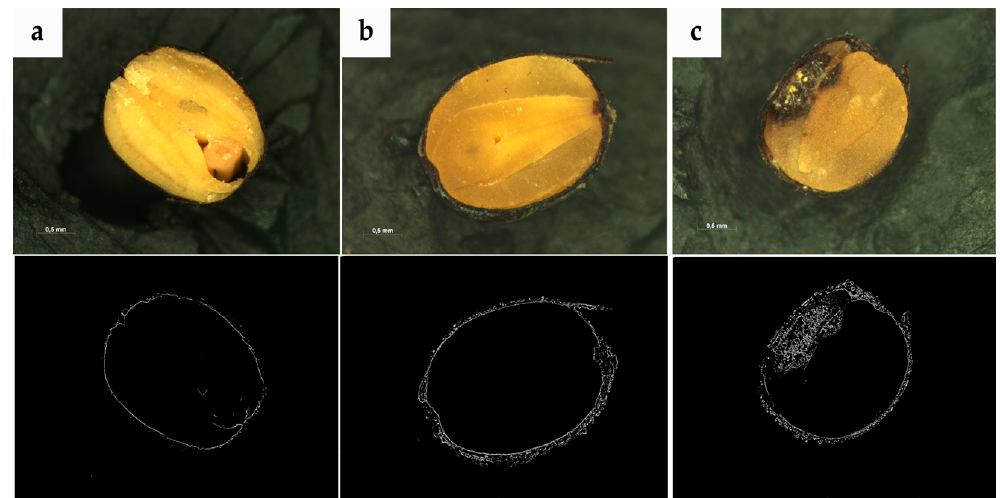
Figure 2. Examples of images that represent rapeseed trials: ( a )—rapeseed free of contamination with an initial moisture content of about 6%, ( b )—contaminated rape seeds stored in conditions characterized by 16% seed moisture content and at a temperature of 25 °C, ( c )—contaminated seed stored in conditions characterized by 16% seed moisture content and at a temperature of 30 °C.